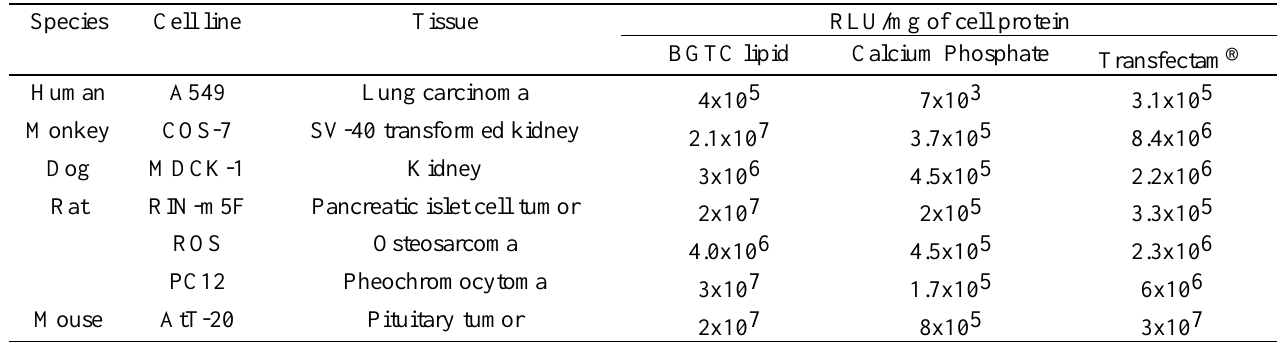
Table 1. Luciferase expression in various mammalian cell lines transfected with either lipid BGTC, calcium phosphate or Transfectam®